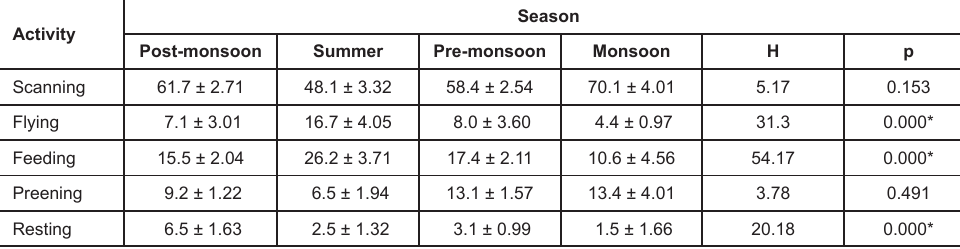
* Differ significantly (Kruskal-Wallis test, p < 0.05) between seasons